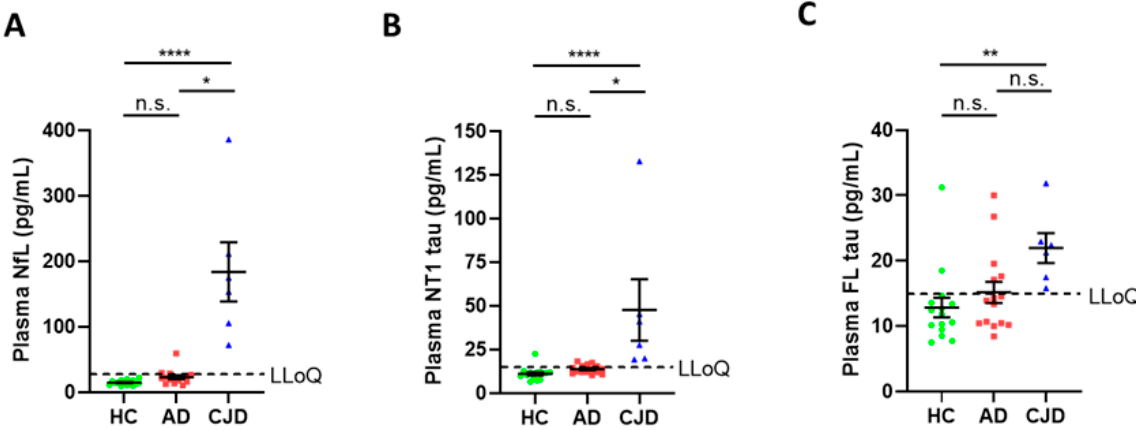
Figure 3. Plasma NfL, NT1-tau and FL-tau are elevated in CJD compared to HC and AD subjects. Study 2 samples included plasma from 15 HC (green circles) and 15 AD (red squares) subjects collected at UCSD, and from 6 CJD (blue triangles) subjects collected at UCL. All samples were treated with GuHCl, diluted appropriately, and analyzed with Simoa-based assays for ( A ) NfL, ( B ) NT1-tau, and ( C ) FL-tau. Each point represents a single individual and means ± SEM are indicated. Differences between groups were assessed with Kruskal–Wallis H test followed by Dunn’s post-hoc test. Plasma levels of NfL, NT1, and FL-tau were elevated in CJD compared to controls and AD subjects. n.s. non-significant; * p < 0.05; ** p < 0.01; **** p < 0.0001. Note: because of the 10-fold dilution required to mitigate interference by GuHCl many AD and control values were below the reliable limit of quantitation; in contrast, when AD and HC samples were analyzed without addition of GuHCl NfL, NT1-tau and FL-tau were readily detected (see Supplemental Figure S4).